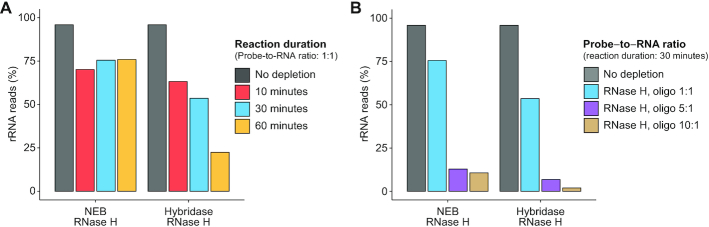
Optimization of RNase H reaction conditions. (A) Proportion of rRNA-aligning reads of total mapped reads (% rRNA reads), for un-depleted and RNase H depleted samples for two RNase H enzymes and various reaction times with probe-to-RNA fixed to 1:1, or (B) various probe-to-RNA ratios with reaction time fixed to 30 min. The same RNA sample isolated from Bacteroides dorei was split for rRNA depletion across different reaction conditions.